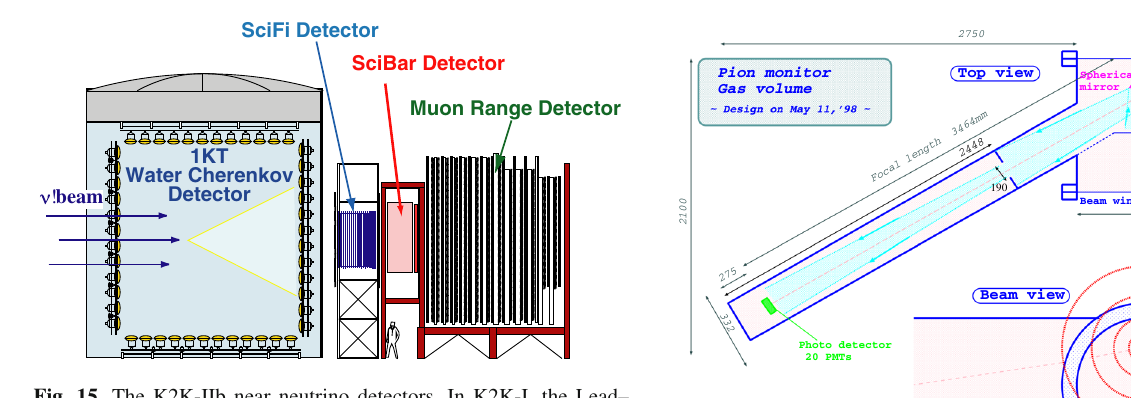
beam assuming azimuthal symmetry of the distribution. The top was aligned to be on the beam center. The reflection angle with respect to beam direction is 30 ◦